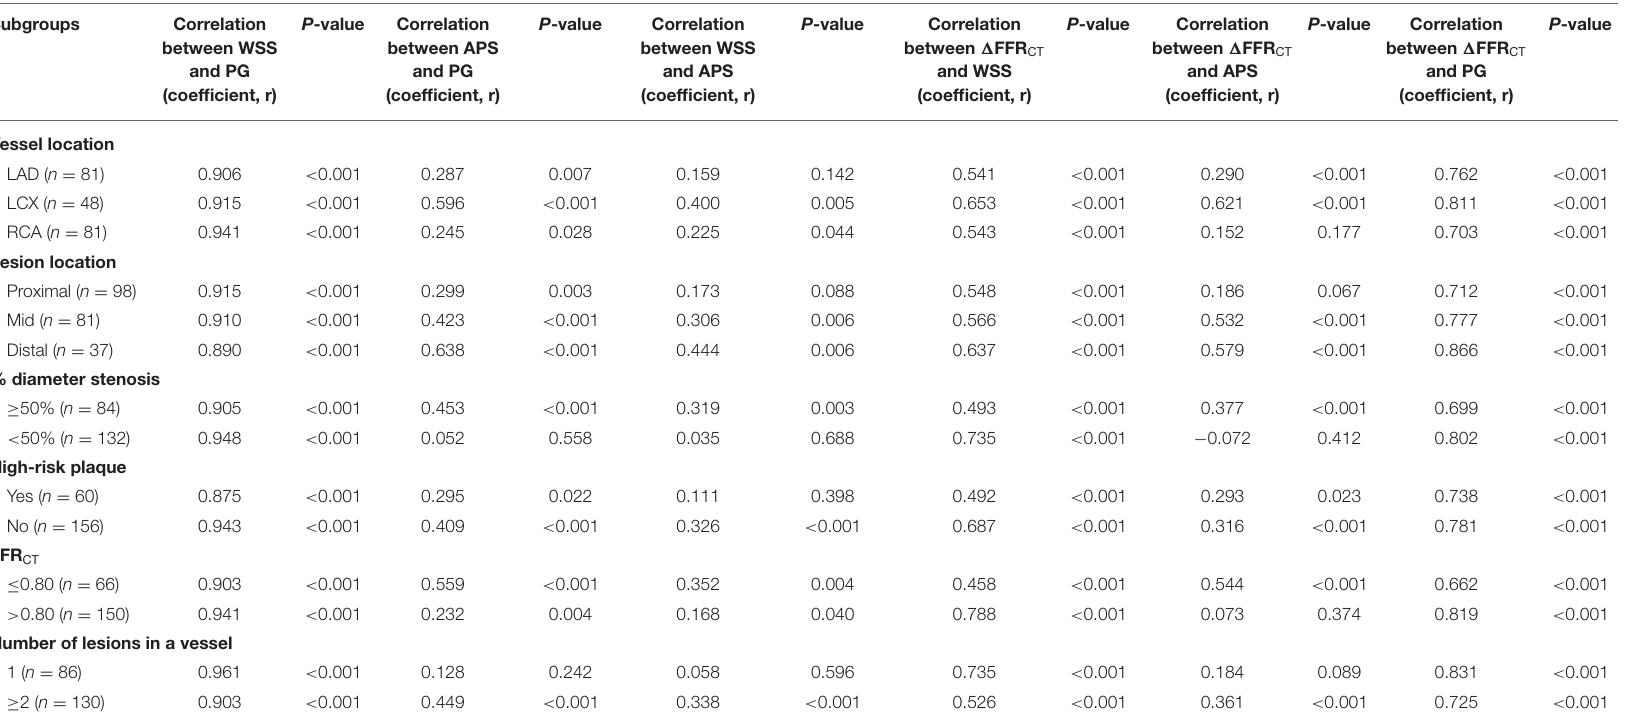
TABLE 2 | Correlation among local hemodynamic parameters in various lesion